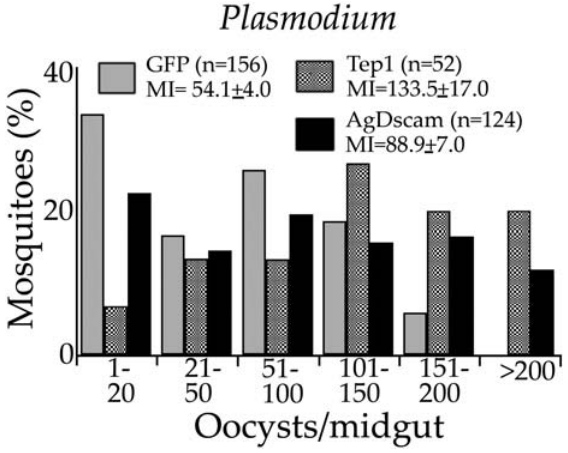
Figure 3. AgDscam Is Implicated in Anti- Plasmodium Defense RNAi-mediated depletion of AgDscam from adult female mosquitoes resulted in increased permissiveness to P. berghei infection, as indicated by a 59%–99% increase in oocysts numbers in four independent assays. The figure presents the frequency distributions of oocysts pooled from four independent assays where MI indicates mean intensity of infection (oocysts number) plus/minus standard error, and n indicates the total number of mosquitoes in each experiment. Infection levels in AgDscam - silenced mosquitoes were comparable to the positive control Tep1 dsRNA -treated mosquitoes [44]. DOI: 10.1371/journal.pbio.0040229.g003